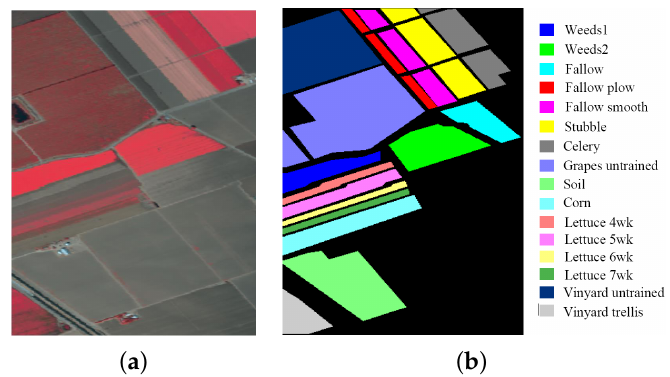
Figure 4. SA data set: ( a ) RGB composite image; ( b ) Ground-truth